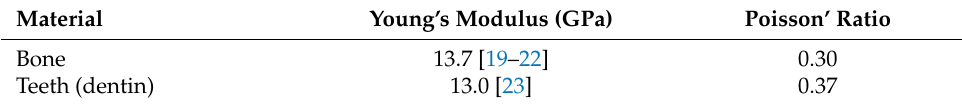
Figure 2. Stress-strain curves of materials used to model mouthguard protection: ( a ) EVA; ( b ) EVA Foam. Table 3. Mechanical properties of the isotropic linear elastic